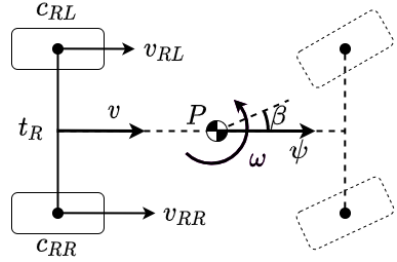
Figure 1. Two-wheel odometry